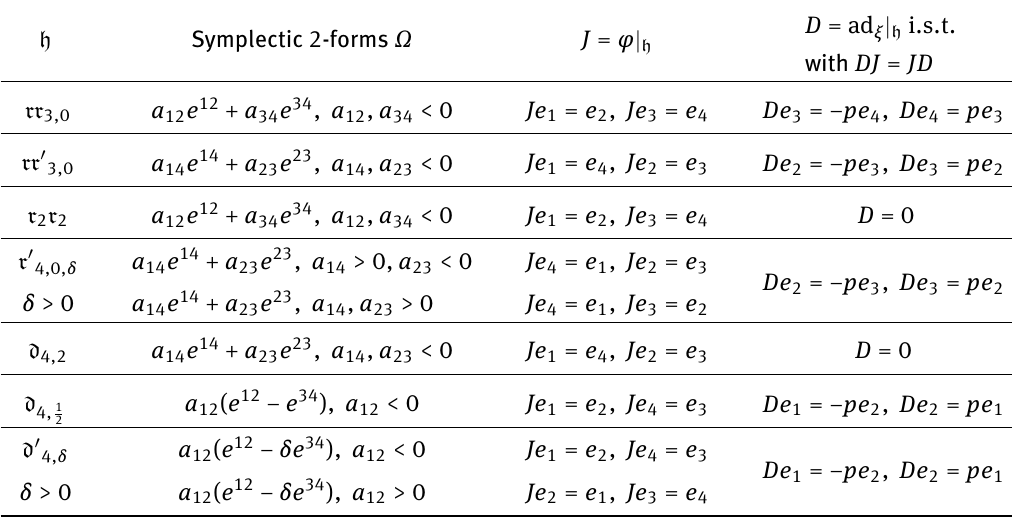
Table 2: 4 D Kähler Lie algebras giving rise to 5 D coKähler Lie